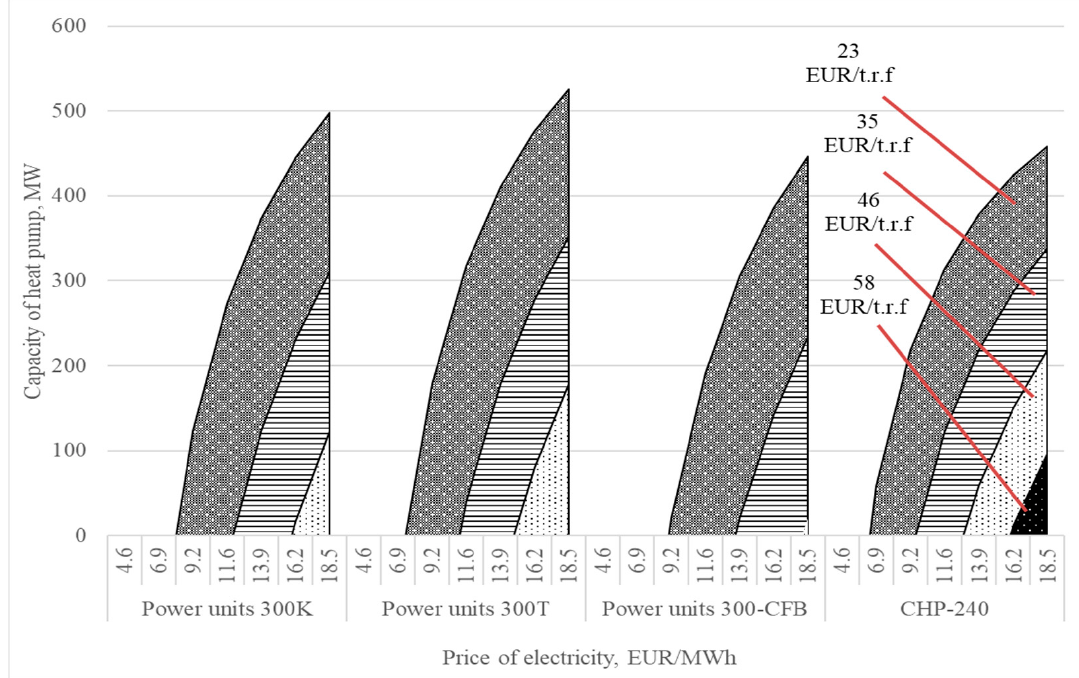
Figure 9. The range of permissible HP capacities with a TPP capacity of 240–300 MW.